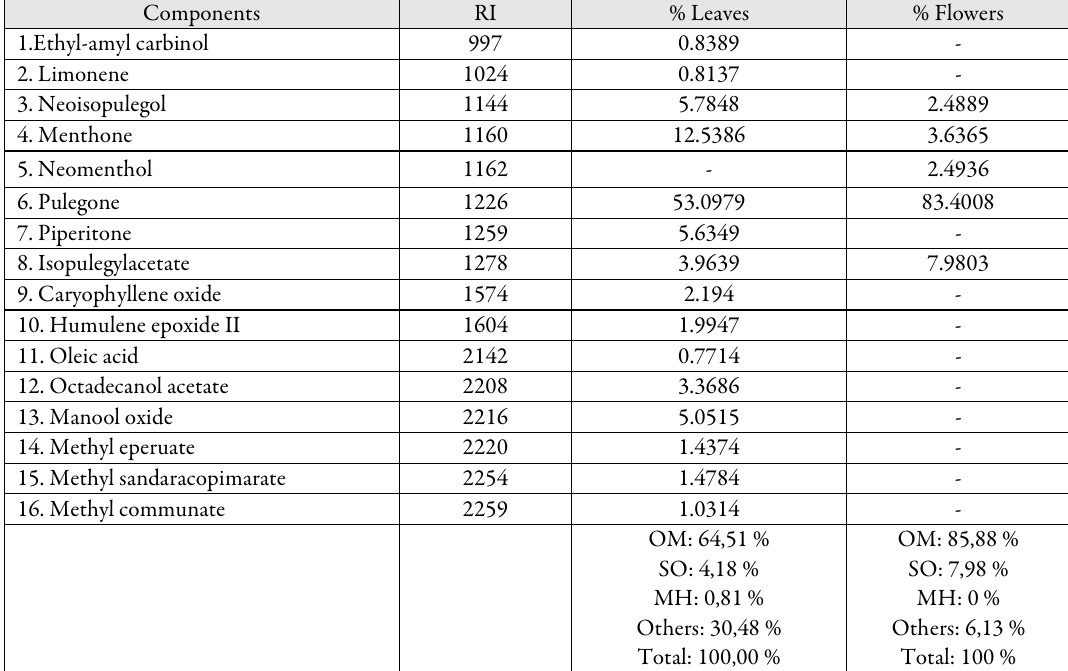
Table 2. Chemical composition of leaves and flowers of essential oils of M. pulegium identified by GC